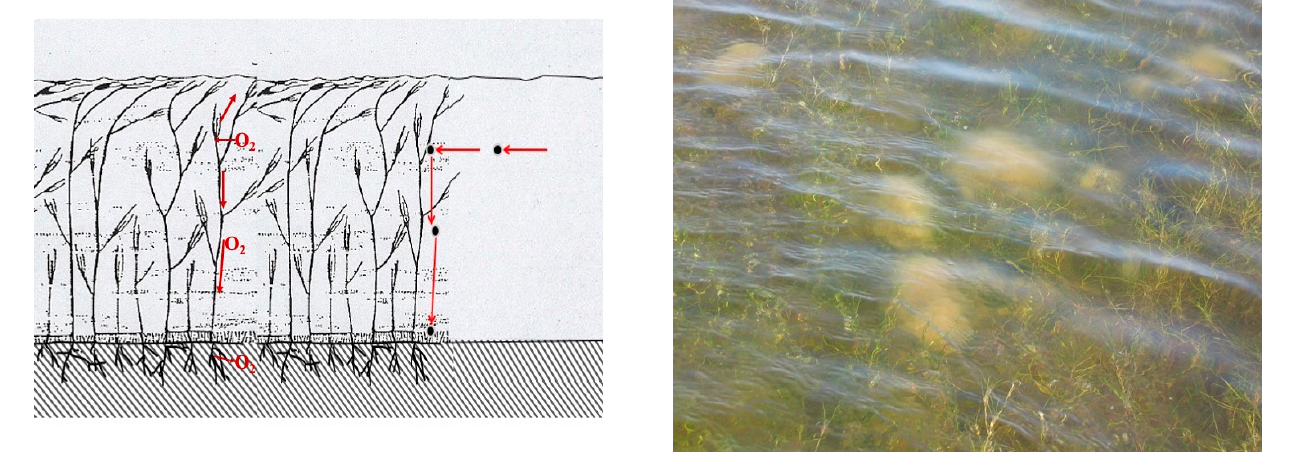
Figure 7. On the left, the Magnoliophyta Ruppia spiralis produces oxygen by photosynthesis, part of which escapes into the water column and then, for good measure, into the atmosphere, another part of which is conducted along the stem and reaches the hypogeal apparatus, from which it can diffuse into the sediment. Dense meadows can be an impediment to water movement and particulate matter suspended in the water column, which bumps into the fronds and eventually settles around and within the meadow, enriching surface sediments of OM. On the right, a R. spiralis meadow has reached the surface of the water column. Thalli of the Chlorophyta Cladophora vagabunda , floating on the meadow, and R. spiralis spiral flower peduncles can be observed.